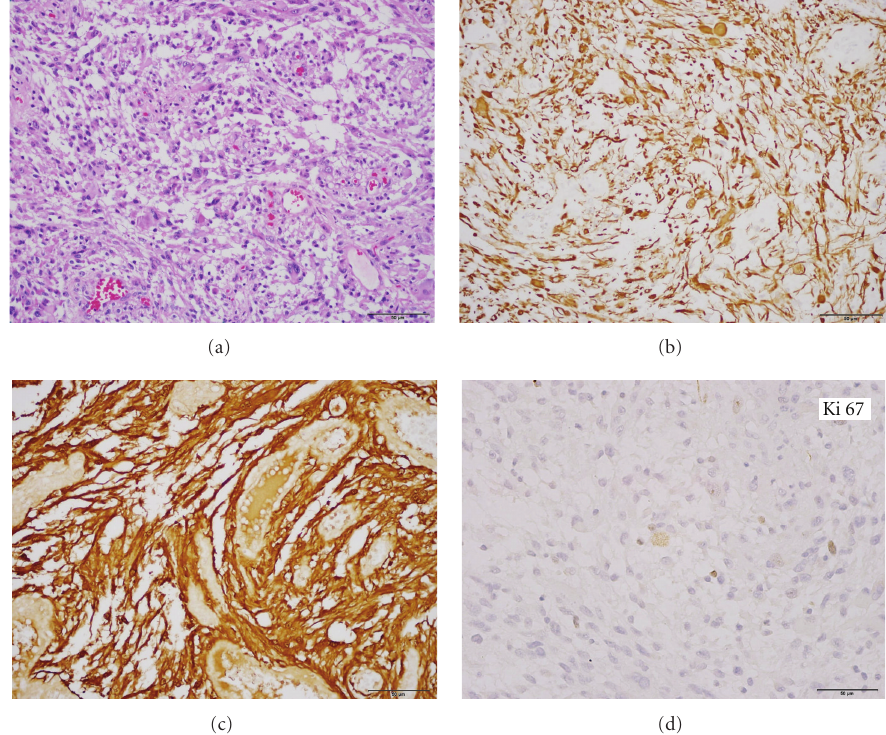
Figure 2: Histopathological and immunohistochemical (GFAP in(b), S-100 in (c)and KI-67 in (d)) features of the lesion. Hematoxylin and eosin stain (HE—(a)) showing perivascular pseudorosettes (anuclear zones formed by radially arranged tumor cell processes surrounding central blood vessels).